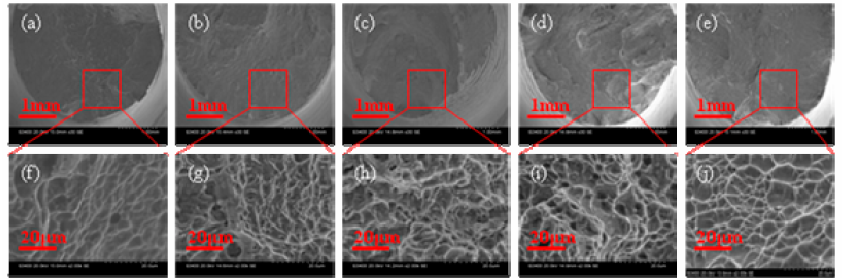
Figure 11. Fractographs of selective laser melting TC4 titanium alloy of tensile test at room temperature. ( a ) As-deposited before normalizing (30X), ( b ) 810 ◦ C / 2 h / AC(30X), ( c ) 870 ◦ C / 2 h / AC, (30X) ( d ) 930 ◦ C / 2 h / AC(30X), ( e ) 990 ◦ C / 2 h / AC(30X), ( f ) As-deposited before normalizing (2kX), ( g ) 810 ◦ C / 2 h / AC (2kX), ( h ) 870 ◦ C / 2 h / AC (2kX), ( i ) 930 ◦ C / 2 h / AC (2kX), ( j ) 990 ◦ C / 2 h / AC